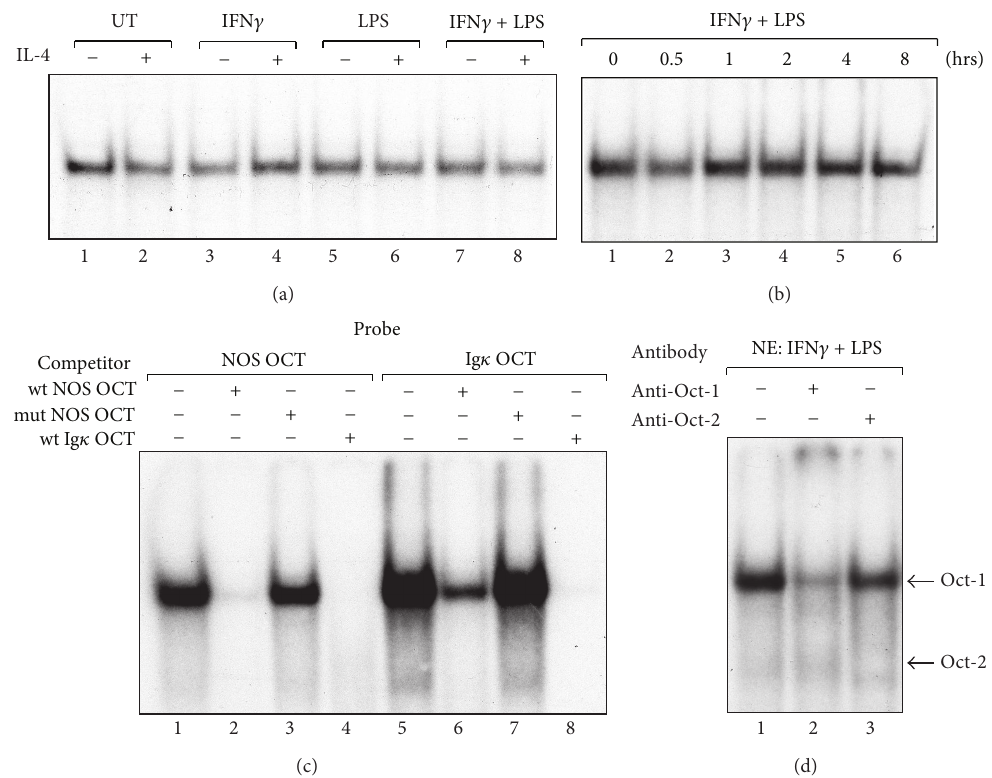
Figure 6: Analysis of OCT DNA-binding activity in nuclear extracts from RAW264.7 cells. (a) Effect of IL-4 treatment on OCT DNA-binding activity. RAW264.7 cells were treated with medium alone or IL-4 (10ng/mL) for 30min prior to stimulation with IFN 𝛾 (10ng/mL) and/or LPS (100ng/mL) for 4 hours before the preparation of nuclear extracts. The OCT binding activity was assessed by EMSA. (b) OCT DNA- binding activity in nuclear extracts from RAW264.7 cells treated with IFN 𝛾 and LPS. RAW264.7 cells were cultured in the presence of IFN 𝛾 (10ng/mL) and LPS (100ng/mL) for the indicated time prior to the preparation of nuclear extracts. In total, 10 𝜇 g of each nuclear extract was analyzed for OCT binding activity by EMSA. (c) Analysis of OCT DNA-binding affinity to Nos2 OCT by an oligonucleotide competition assay. Nuclear extracts were prepared from RAW264.7 cells stimulated with IFN 𝛾 (10ng/mL) and LPS (100ng/mL) for 30min. The OCT DNA-binding activity was determined by EMSA using radio-labeled OCT oligonucleotides corresponding to the Nos2 OCT (NOS OCT) site or the immunoglobulin 𝜅 chain OCT site (Igk OCT) in the presence or absence of a 25-fold excess of unlabeled wild-type (wt) or mutant (mut) oligonucleotide, as indicated. (d) Antibody super-shift assay for Nos2 OCT. Nuclear extracts (NE) from RAW264.7 cells stimulated with IFN 𝛾 (10ng/mL) and LPS (100ng/mL) for 30min were incubated with the indicated antibodies (1 𝜇 g each) before analysis of the binding activity, as described